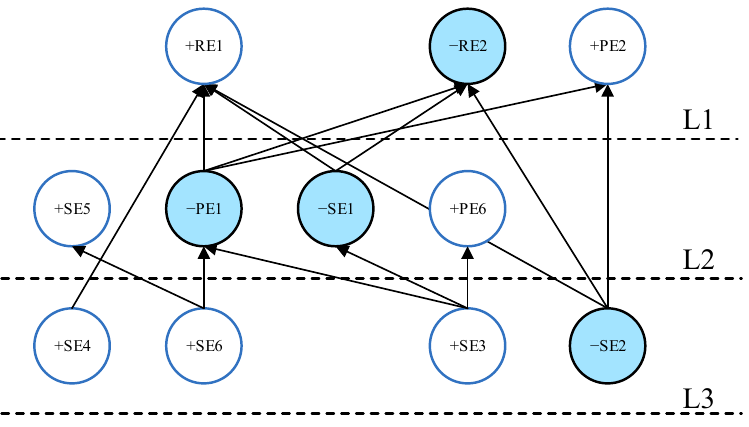
(cid:12) (cid:12) (cid:12) (cid:12) > 4.70. (cid:12) C ij (cid:12)